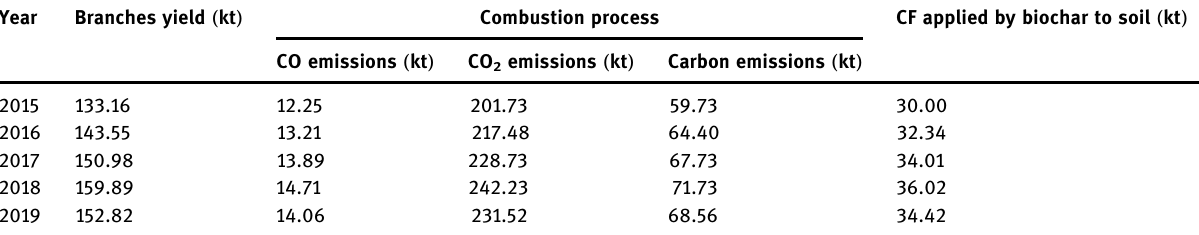
Table 7: Carbon emission from combustion and carbon sequestration potential of pruned wolfberry branches Year Branches yield ( kt ) Combustion